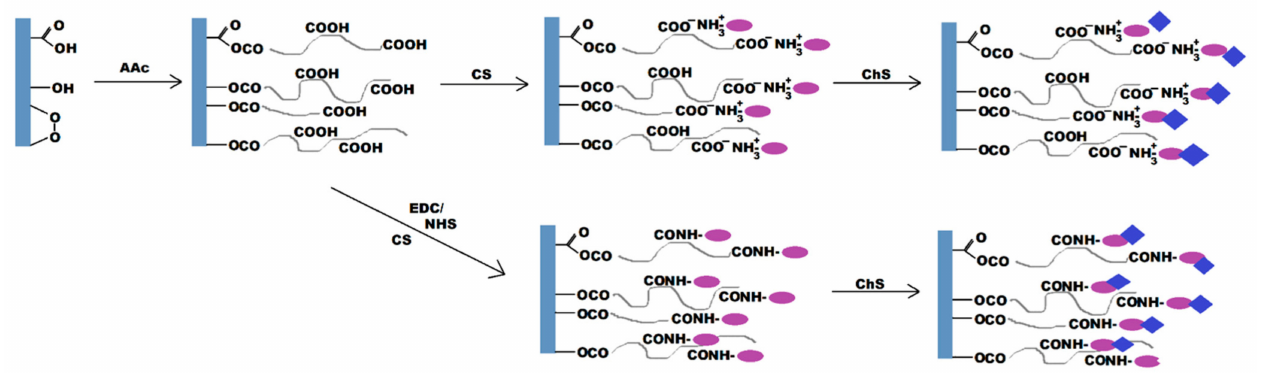
Figure 1. Plasma post-irradiation grafting of acrylic acid (AAc) onto the polylactic acid (PLA) surface followed by immobilization of chitosan (CS) through either direct or carbodiimide coupling and chondroitin sulfate (ChS) molecules